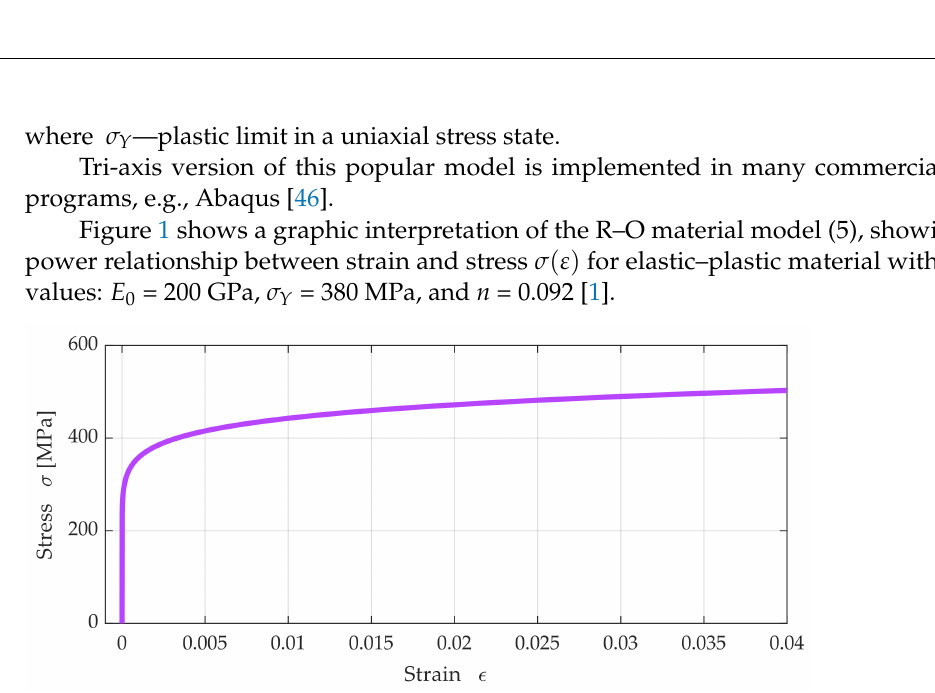
Figure 1. An example diagram σ ( ε ) generated for elastic–plastic material with reference values: E 0 = 200 GPa, σ Y = 380 MPa and n = 0.092.